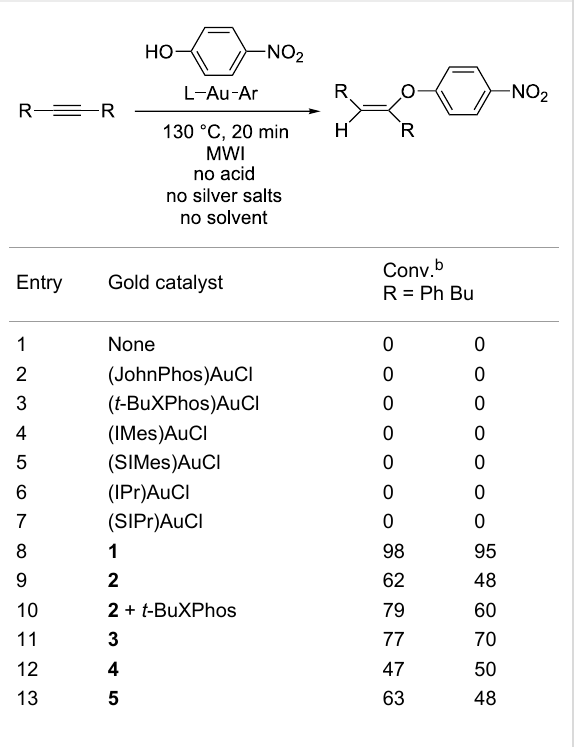
Table 1: Hydrophenoxylation of unactivated internal alkynes. a